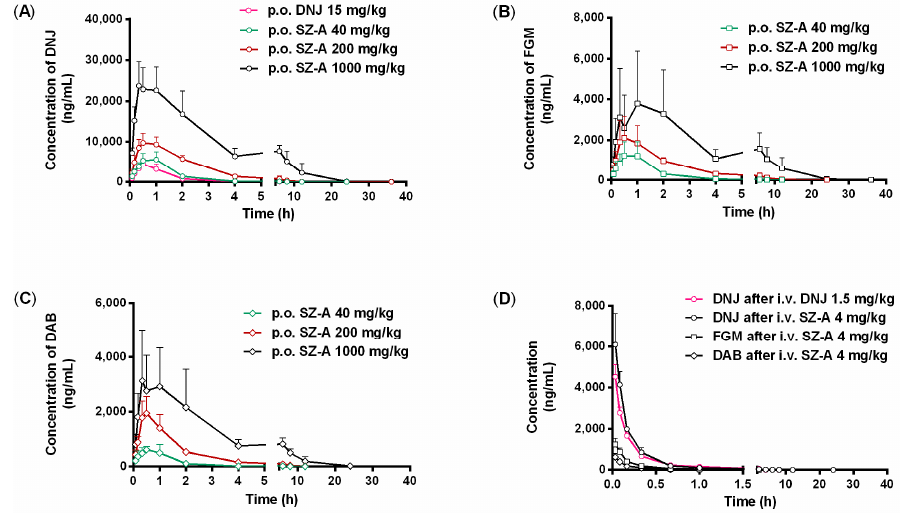
Figure 2. Mean plasma concentration-time curves s in rats after oral (( A ) DNJ; ( B ) FGM; ( C ) DAB) and intravenous ( D ) administration of SZ–A and purified DNJ ( n = 5).